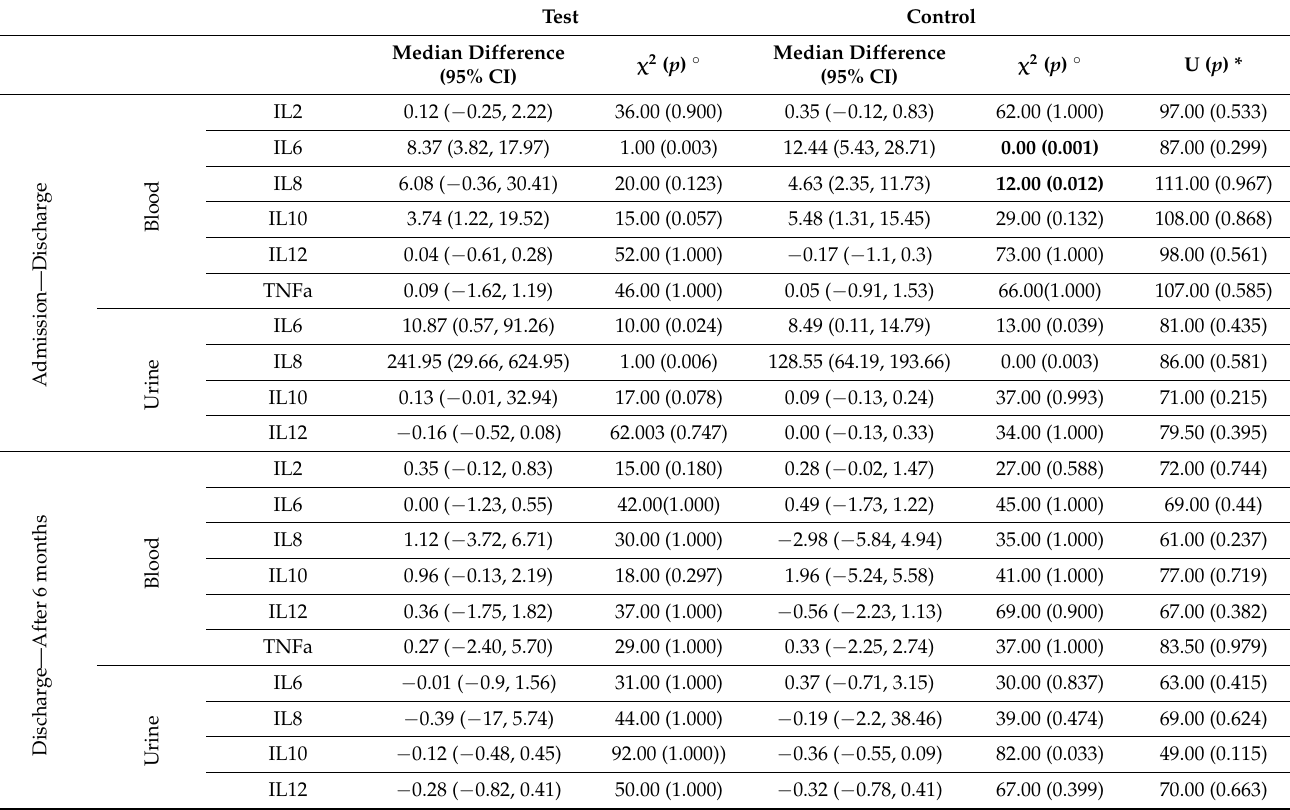
Table 3. Comparison of the interleukin levels in blood and urine measured at admission, on discharge, and after six